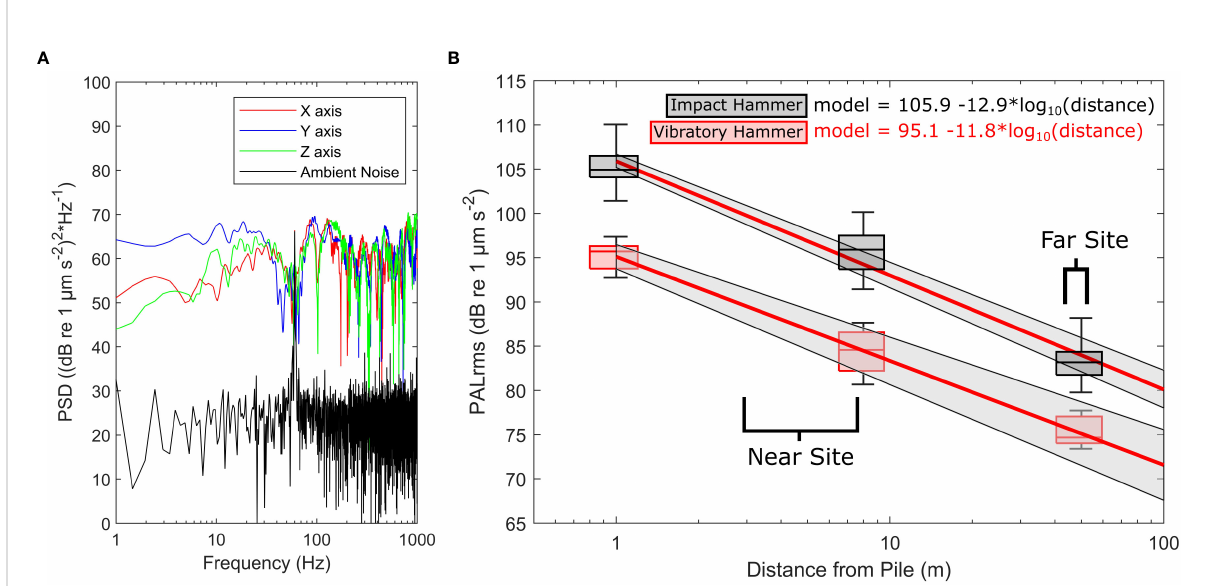
FIGURE 3 (A) PALrms propagation model labeled with the brackets denoting the distances of the experimental cages at the near and far sites. Particle acceleration was measured at multiple distances: 1, 8, and 50 m from the pile driving. The red line represents the empirically-based model fi t, and the shaded region denotes the 95% con fi dence interval. (B) Power spectral density curves of the impact hammer and ambient noise measured at 1 m. The PSD curves were generated from a 1 min segment during both noise treatments, and the x (red), y (blue), and z (green) represent the three accelerometer axes during the impact